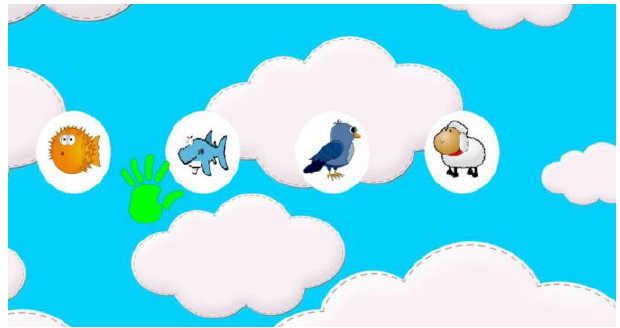
Figure 1. Screenshot of the cognitive upper limb game.